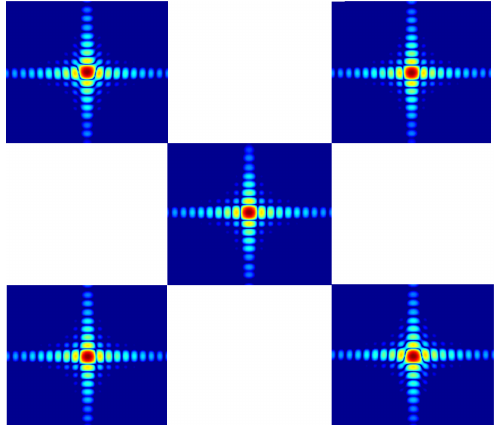
Figure 15. Imaging results of Case 1 with the BTD error compensation.